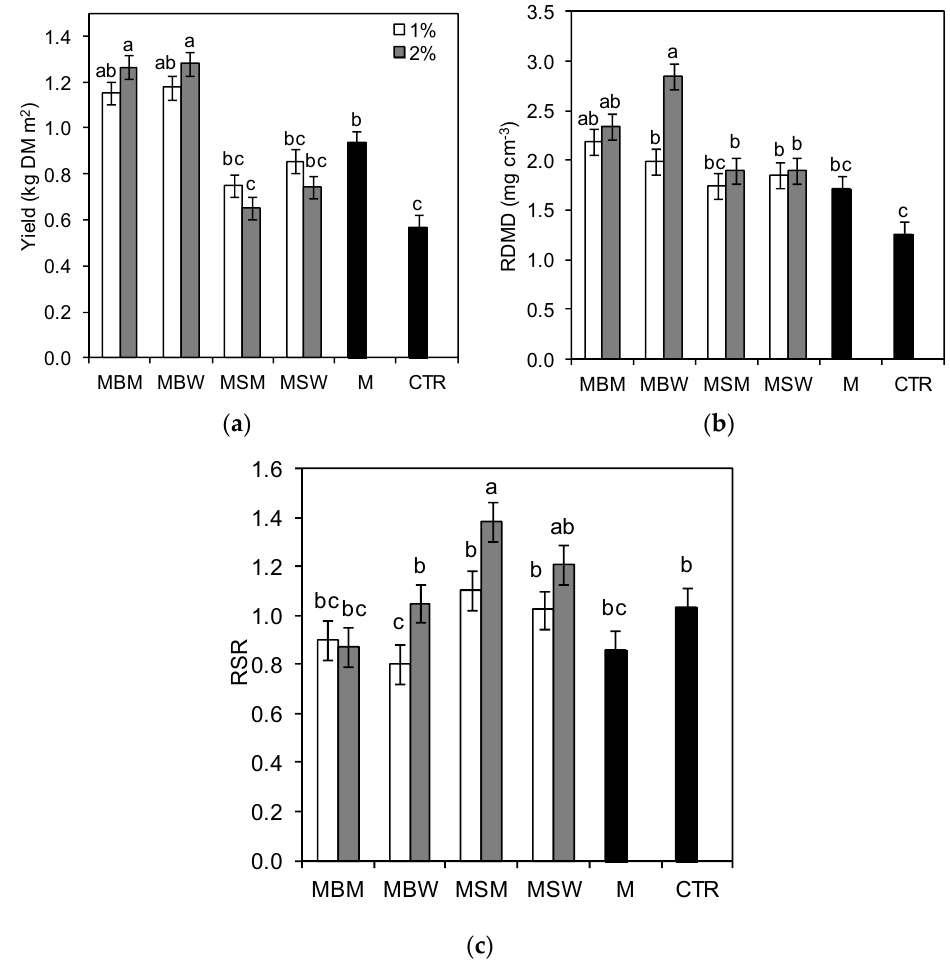
Figure 1. Average (± standard error) of annual yield of above-ground biomass ( a ), root dry matter density (RDMD) ( b ), and root:shoot ratio (RSR) ( c ) for soil amendments treatment. Treatments: wheat straw (MSW), wheat biochar (MBW), Miscanthus straw (MSM) and Miscanthus biochar (MBM), without organic amendments (M) and control treatment (CTR), without organic amendments and mineral fertilization. Different letters on the bars indicate significant differences by the Bonferroni test ( p < 0.05).